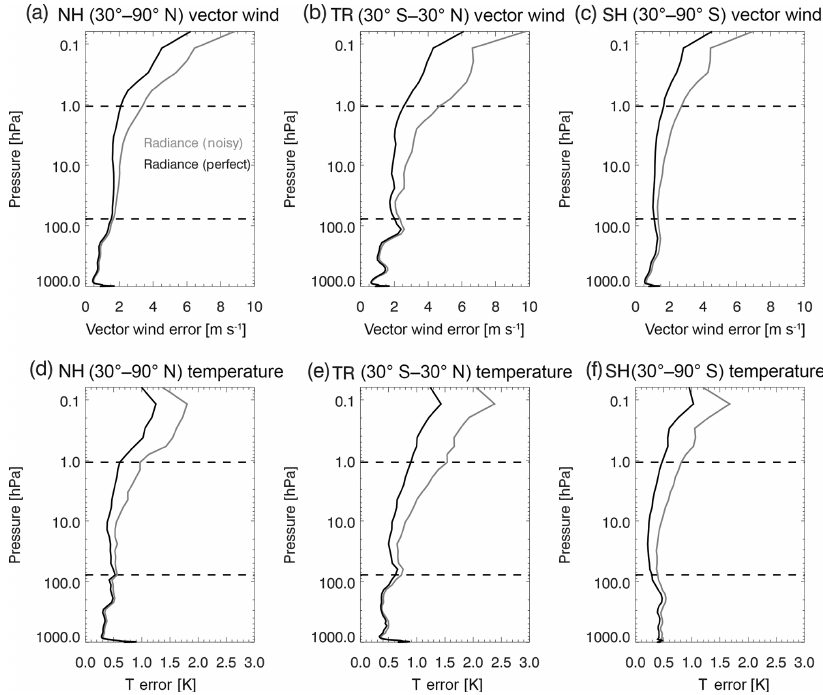
Figure 20. The rms vector wind errors (ms − 1 ) averaged from 25 November to 1 December 2014 for (a) NH, (b) TR, and (c) SH and rms temperature errors (K) for the (d) NH, (e) TR, and (f) SH. Black (grey) lines are for assimilation of perfect (noisy) radiance data. Horizontal dashed lines indicate vertical range of assimilated stratospheric ozone observations. See Table 1, Sect. 5.1.